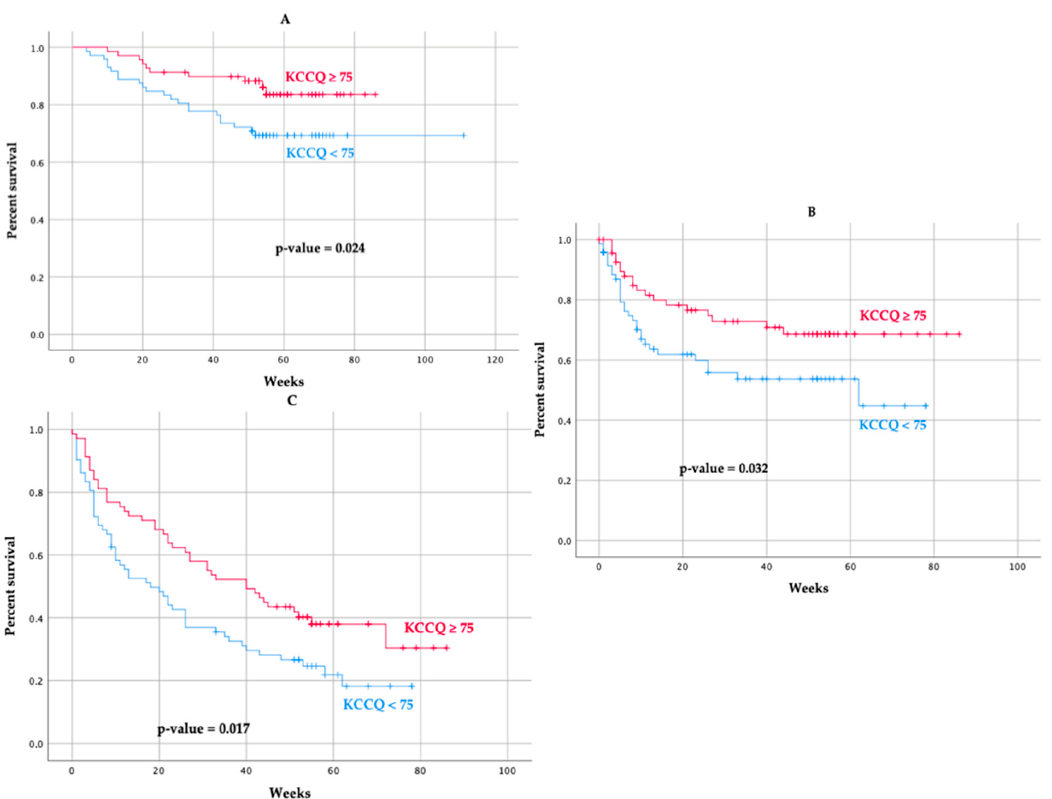
Figure 2. Unadjusted Kaplan–Meier for ( A ) all-cause death, ( B ) heart failure hospitalization, and ( C ) all-cause hospitalization. Table 3. Primary and secondary outcomes during follow-up.